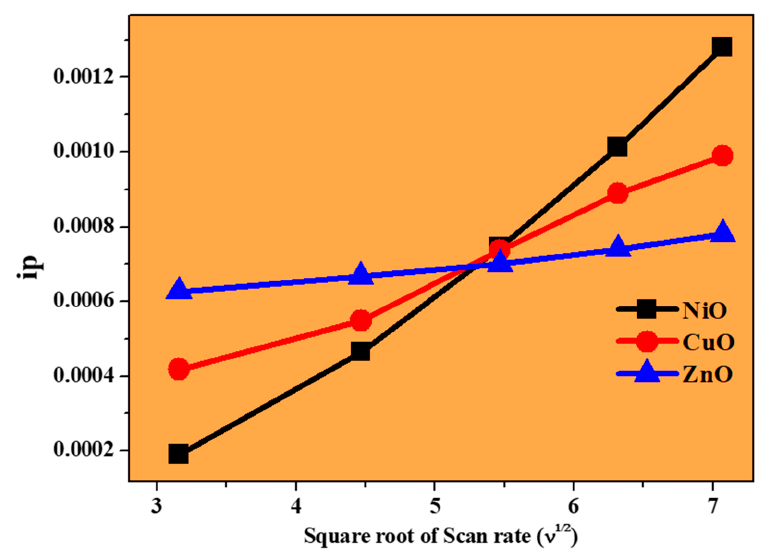
Figure 10. Plot of peak current versus square root of scan rate.